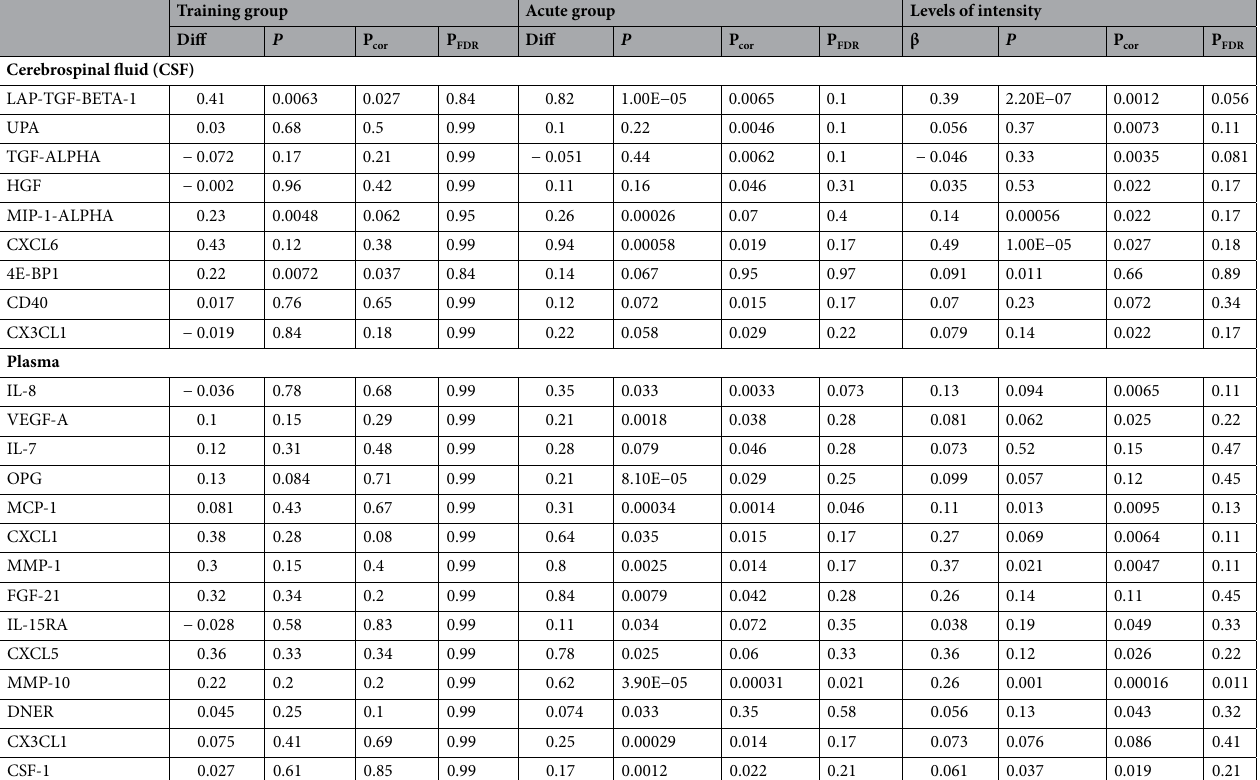
Table 3. Effects of anaerobic exercise on inflammation-related protein levels in cerebrospinal fluid and plasma. Summary statistics of paired Student t tests comparing before-and-after exercise intervention: mean difference (Diff) and significance ( P ). Linear regression model analyses correcting for sample handling variability was also examined (P cor , FDR corrected P FDR ). Additional results are detailed in the supplementary material (Table